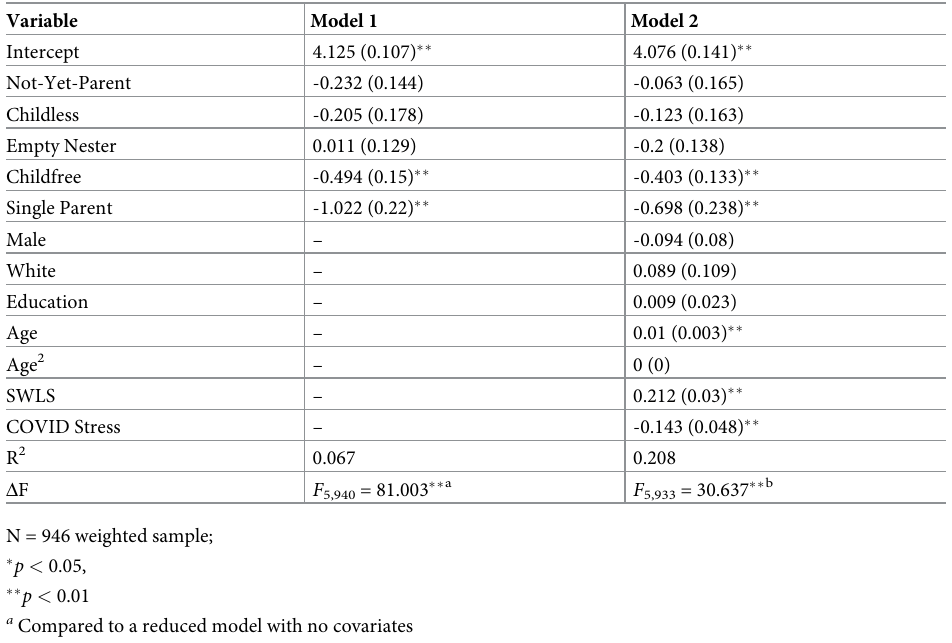
Table 3. Model estimates (DV: Neighborhood